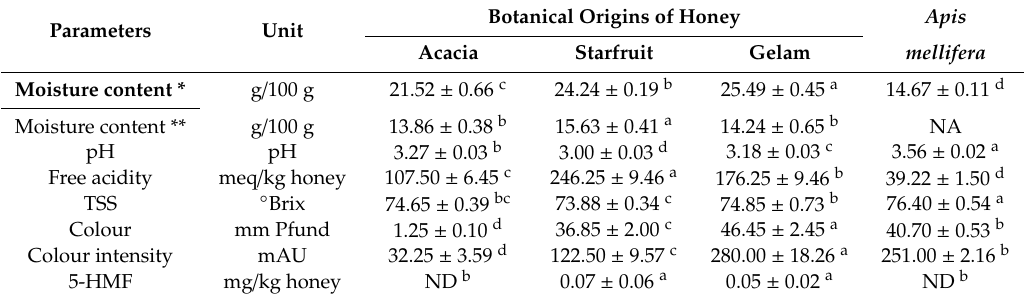
Table 1. Physicochemical characteristics of honey samples from di ff erent botanical origins. Botanical Origins of Parameters Unit